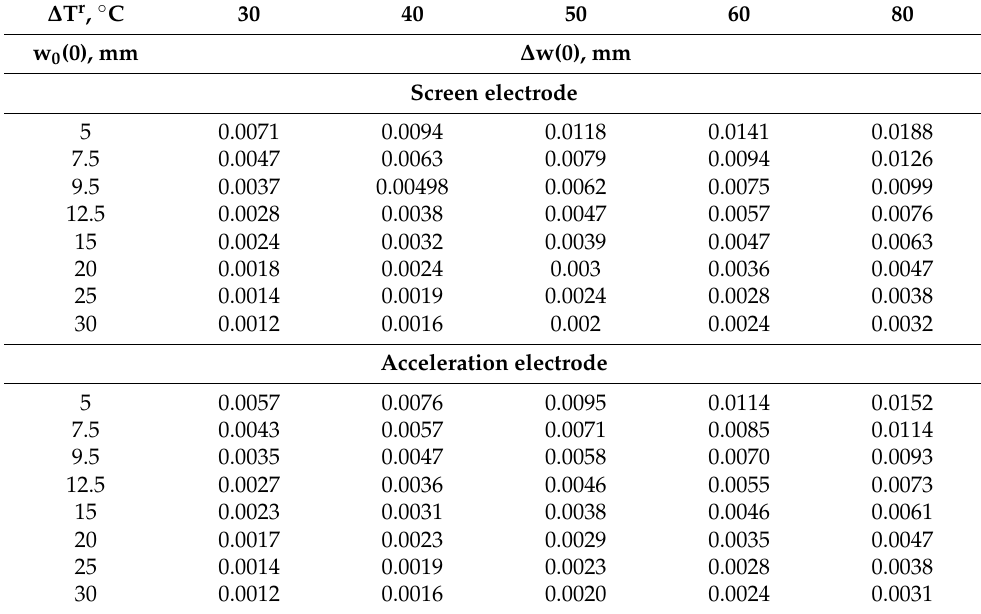
Figure 12. IS acceleration electrode additional deflection (∆w(0)) as a function of initially designed deflection (w 0 (0)) at different levels of temperature drop along AE radius. Table 1. Electrode design deflection simulation results as a function of initially designed deflection and temperature gradient along electrode